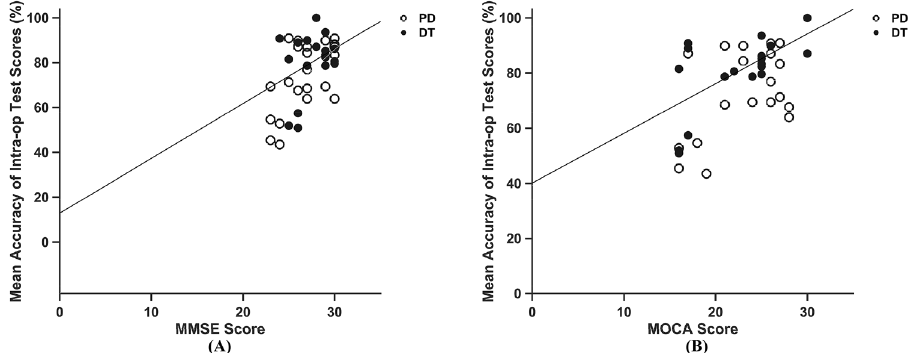
Figure 4. Correlation of the intraoperative memory test scores with the MMSE and MoCA scores. ( A ) Correlation of the intraoperative memory test scores with the MoCA scores. ( B ) Correlation of the intraoperative memory test scores with the MMSE scores. MoCA Montreal Cognitive Assessment, MMSE Mini- Mental State Examination, PD Parkinson’s disease, DT